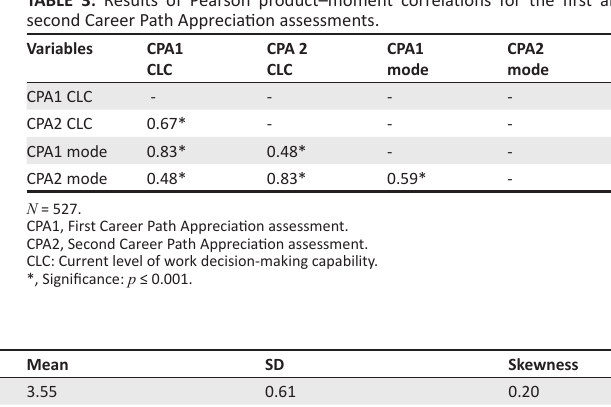
TABLE 3: Results of Pearson product–moment correlations for the first and second Career Path Appreciation assessments.